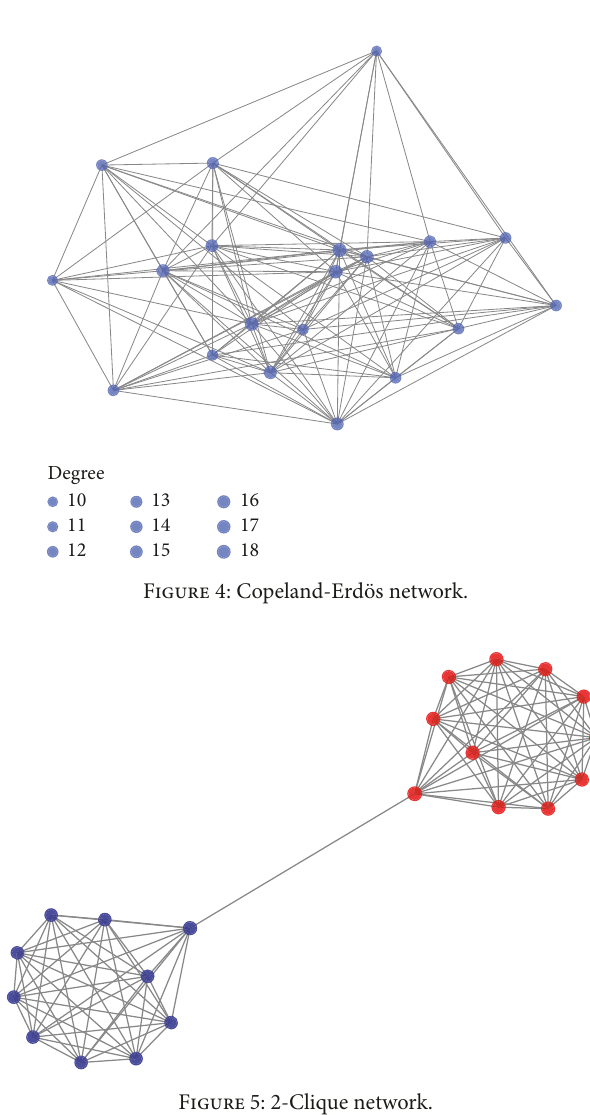
Figure 5: 2-Clique